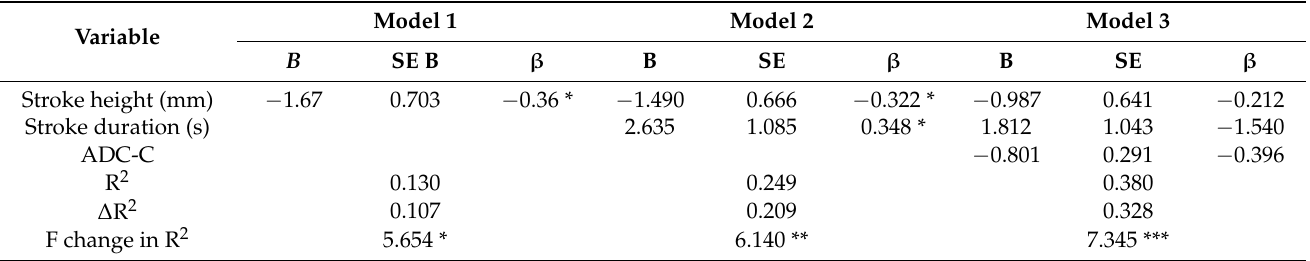
Table 9. Prediction of physical QOL by handwriting measures and ADC subscale among adolescents with